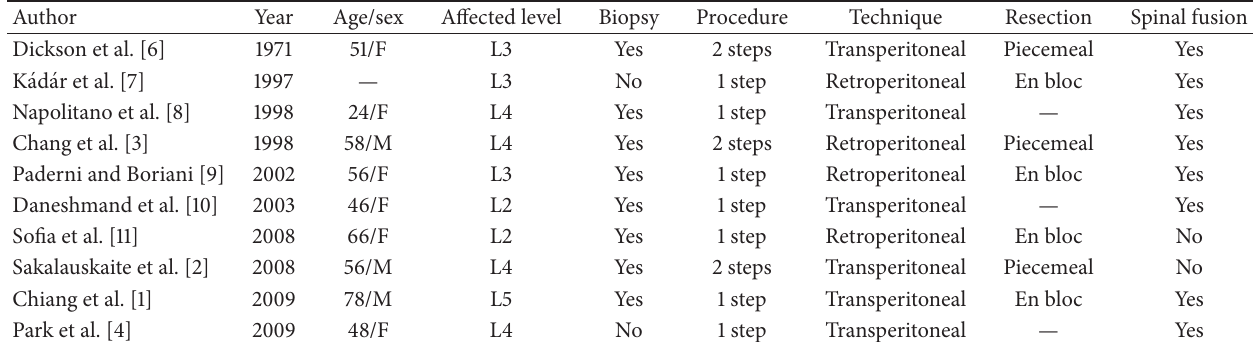
Table 1: Review of the